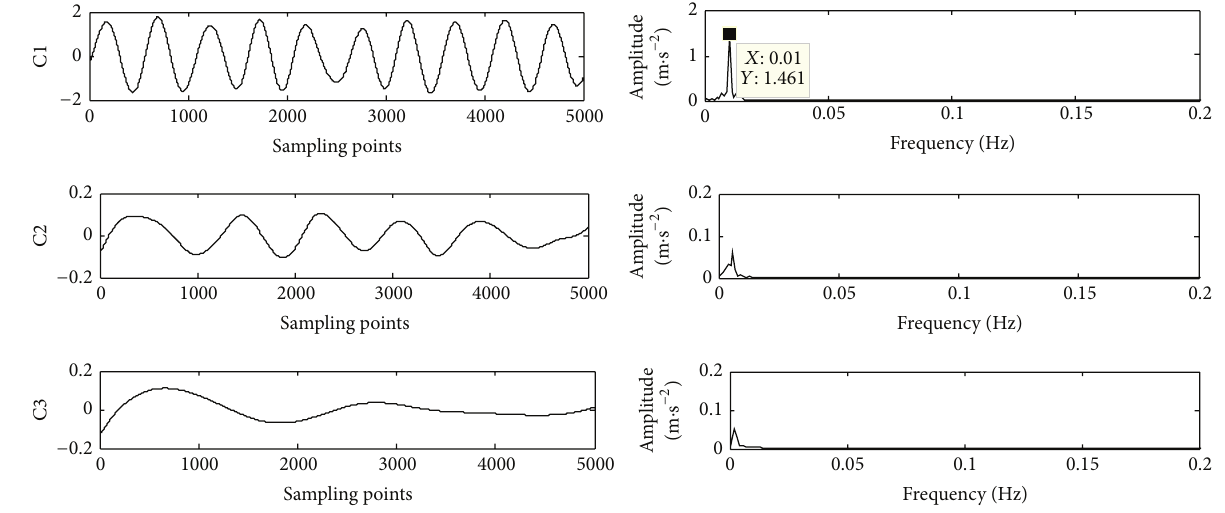
Figure 6: The AMD-EEMD components of stochastic resonance signal and its spectrum. Table 1: The main parameters of the rolling bearing of SKF6205.